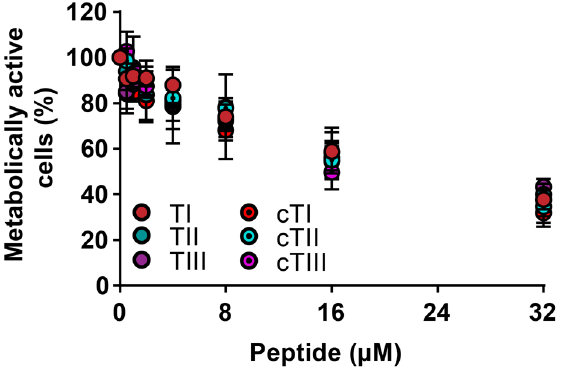
Figure 3. The activity of tachyplesin peptides and their cyclic analogues against an S. aureus ATCC 6538 biofilm. The response curve of biofilm treated with increasing the concentrations of peptide ( n = 4, ± SEM).